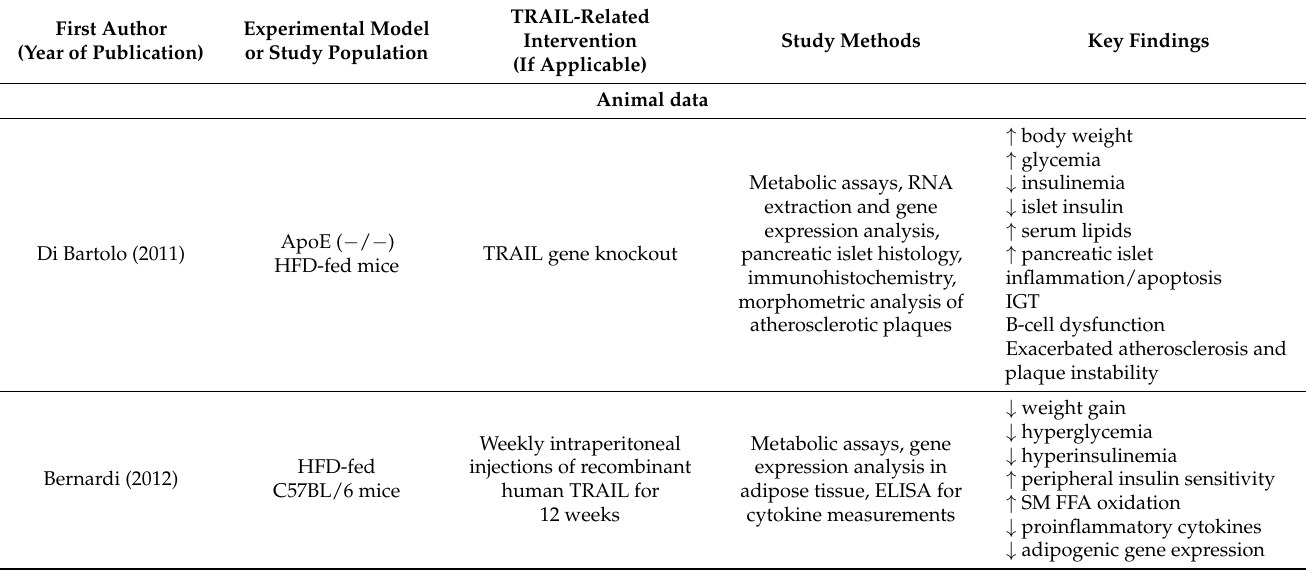
Table 2. A summary of the major experimental and clinical studies investigating the relationship of TRAIL with T2DM in animal models and